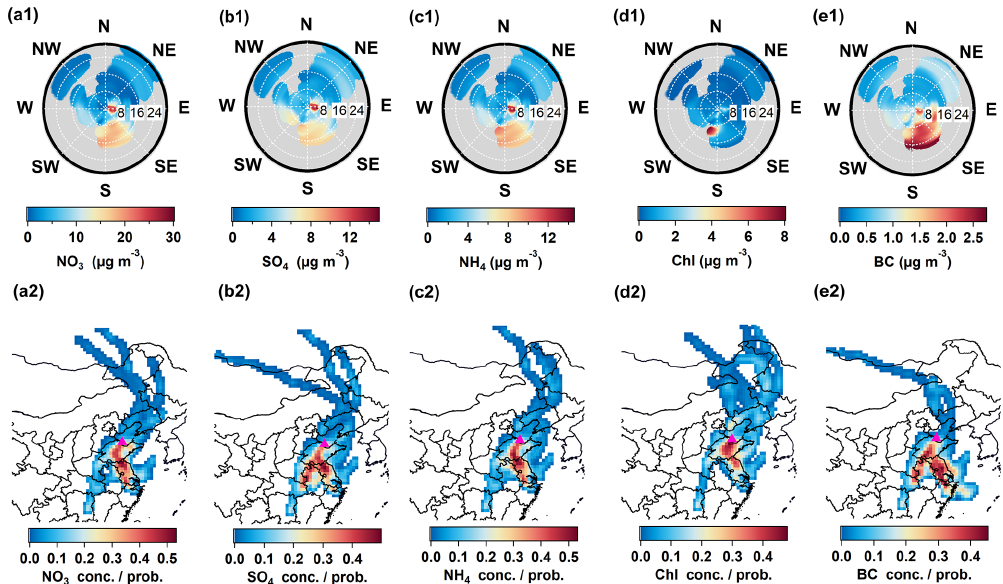
Figure 3. Bivariate polar plots and the results of potential source contribution function (PSCF) from inorganic species, including (a1, a2) NO 3 ; (b1, b2) SO 4 ; (c1, c2) NH 4 ; (d1, d2) Chl; (e1, e2) BC. The unit of wind speed is kmh − 1